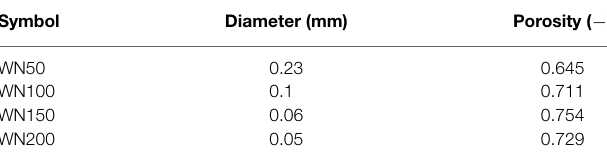
TABLE 2 | Table of regenerator mesh dimensions (Tanaka et al., 1990).